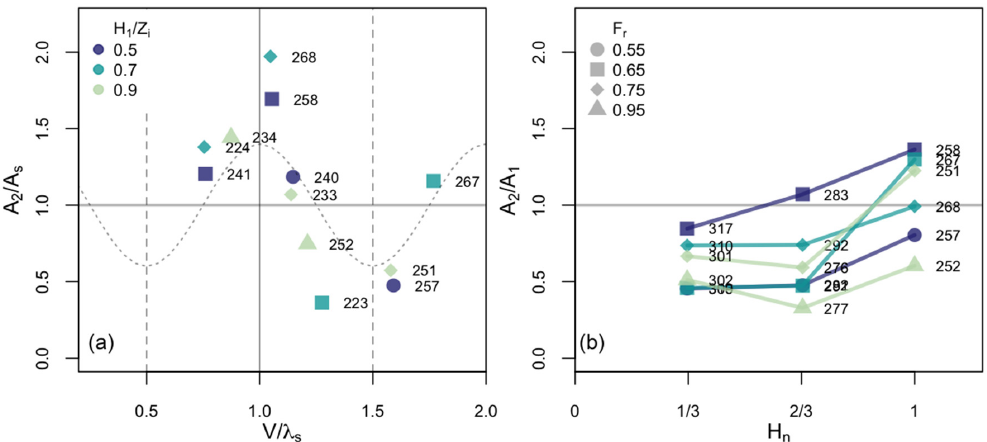
Figure 10. Interference pattern for the trapped lee-wave experiments; ( a ) Amplitude ratio A 2 /A s as a function of dimensionless valley width V/ λ s for twin obstacles ( H n = 1); ( b ) Amplitude ratio A 2 /A 1 as a function of mountain height ratio H n for experiments with equal valley width ( V = 1.8 m). The color of the points corresponds to dimensionless inversion height H 1 /Z i , and the symbol to the Froude number of the experiment F r . Vertical lines in panel ( a ) show full and half-integer values of V/ λ s indicating where constructive and destructive interference is expected. Dotted wavy line indicates possible interference pattern inspired by results of Stiperski and Grubiši ć [29] with the values of minima and maxima obtained from linear no-slip simulations in [29]. Colored lines in panel ( b ) connect experiments with the same set-up ( F r and H 1 /Z i ).